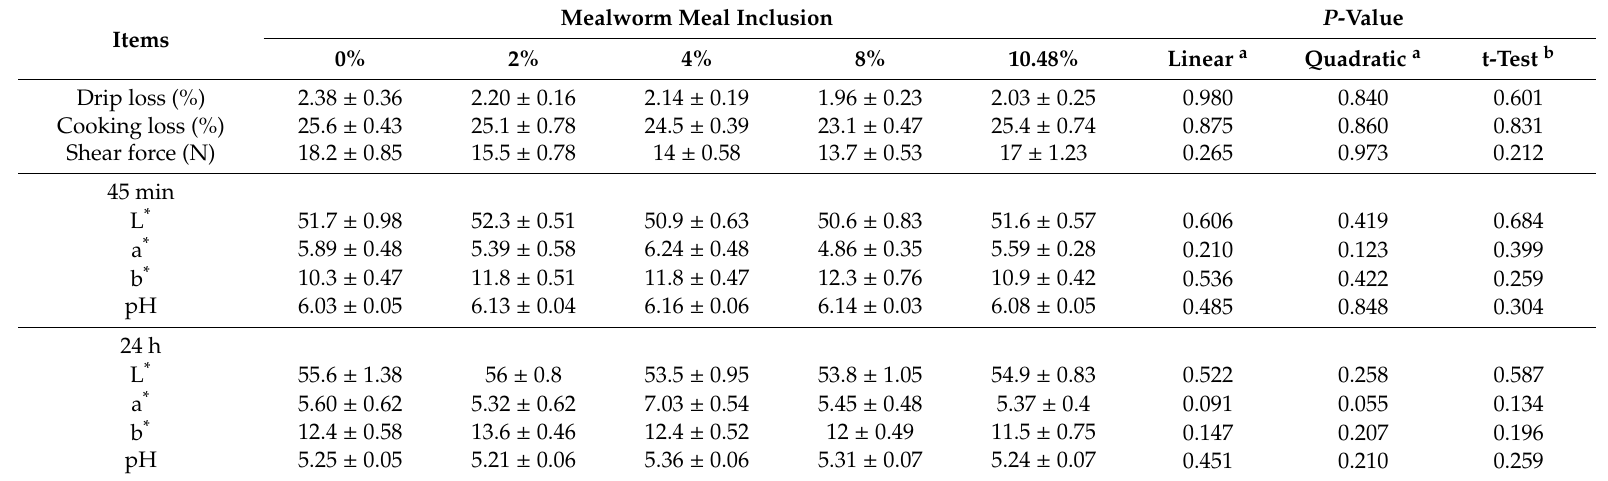
Table 6. Meat quality of the broiler chicks fed on MWM